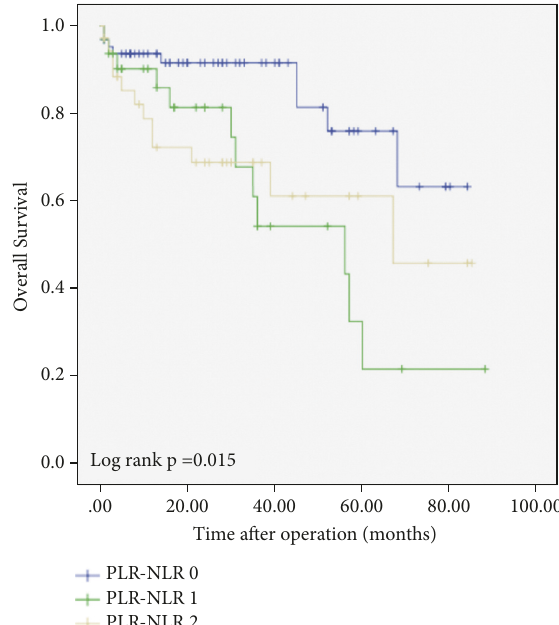
Figure 2: Kaplan–Meier survival plots comparing recurrence free survival for patients with preoperative NLR-PLR score of 0, 1, and